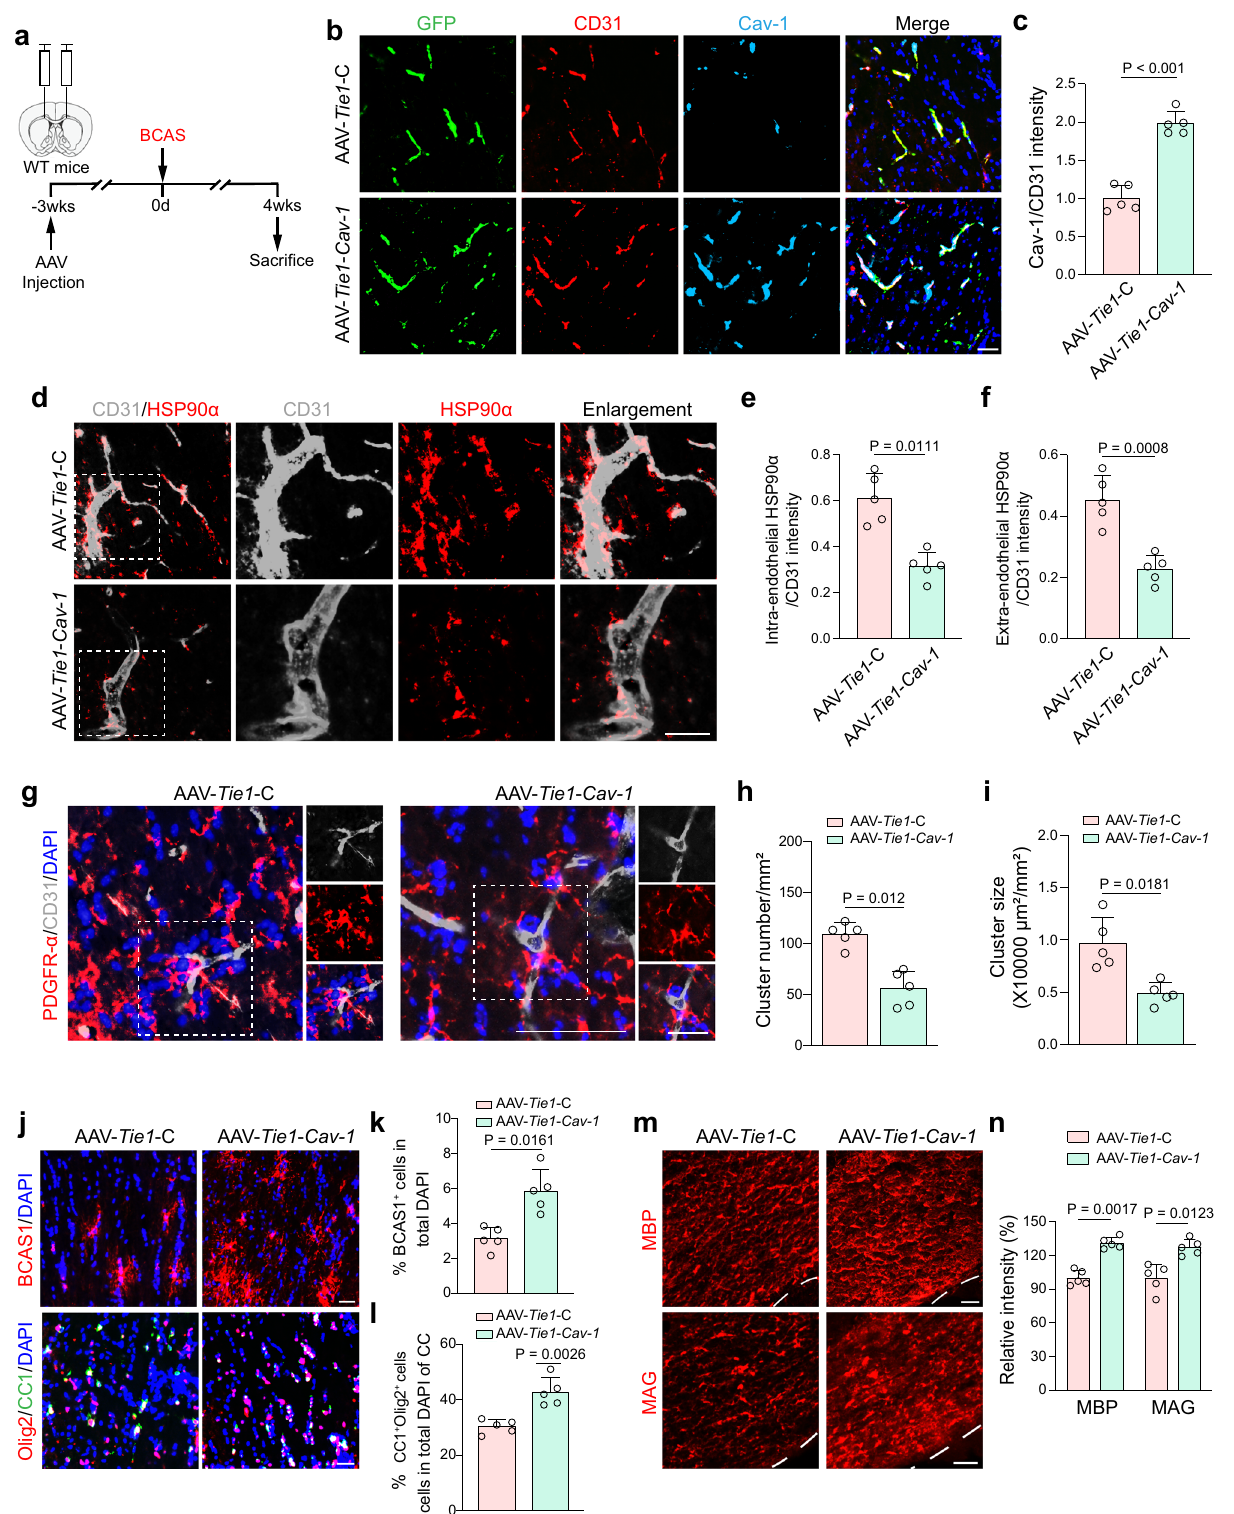
Fig. 4 | Over-expression of endothelial Cav-1 inhibits HSP90 α secretion and attenuates ischemic demyelination. a Experimental fl ow chart. b , c Representative fl uorescent images and quali fi cation of the transfection of GFP (green)reporterAAVintomicrovessels(CD31 + ,red)withenforcedCav-1(lightblue) expressionintheCCofBCASmice( n =5mice/group).Scalebar,20 μ m. d – f Double immunostaining and quali fi cations of CD31 and HSP90 α showing the reduction of HSP90 α induced by AAV- Tie1 - Cav-1 ( n =5 mice/group). Scale bar, 20 μ m. g Representative images showing the PDGFR α + clusters contacting vessels ( n =5